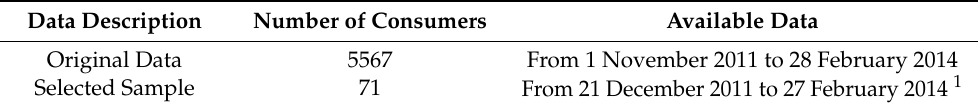
Table 1. Summary of the available dataset and the selected sample.